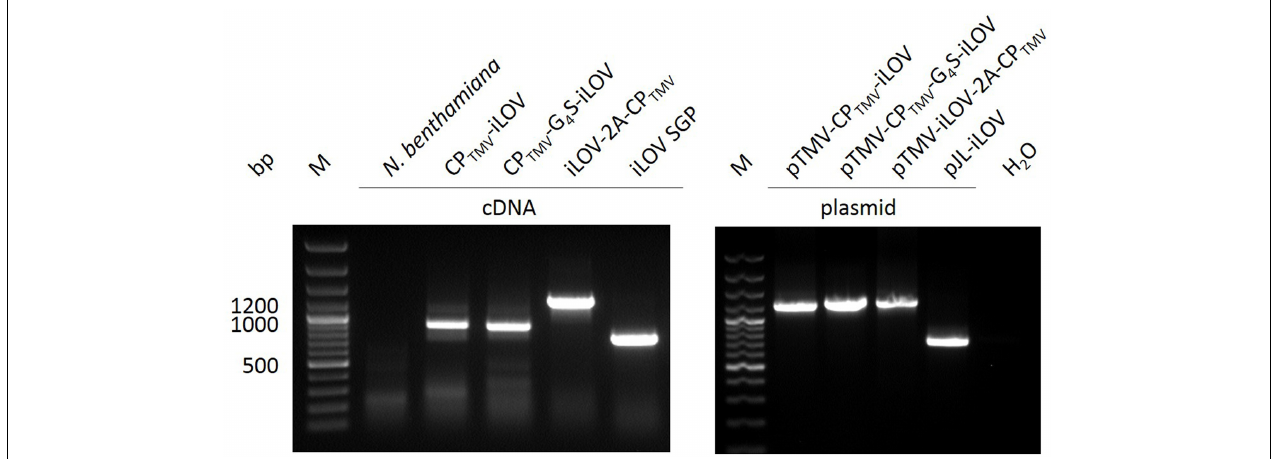
FIGURE 5 | RT-PCR analysis of infected plant material expressing iLOV. RT-PCR products of isolated RNA from N. benthamiana (non-infected plant), and plants infected with